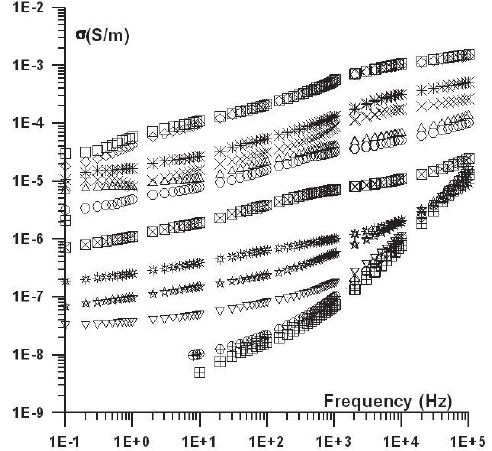
Fig. 2. The variation of the conductivity with fre- quency at different levels of relative saturations (in volume). 4% 0, 8% 0, 11% 0, 14% 0, 18% 0, 25% 0, 32% 0, 40% 0, 50% 0, 55% 0, 96% 0, 100% 0, re- spectively. There are many symbols that are not